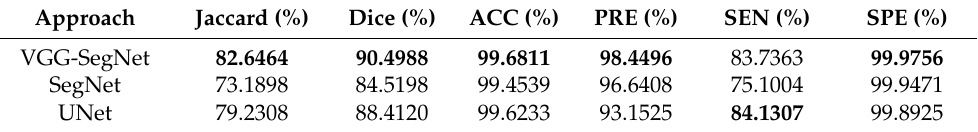
Figure 5. Segmentation results attained with considered CNN models. Table 3. Performance evaluation of CNN models on sample lung CT image. Best values are shown in bold.